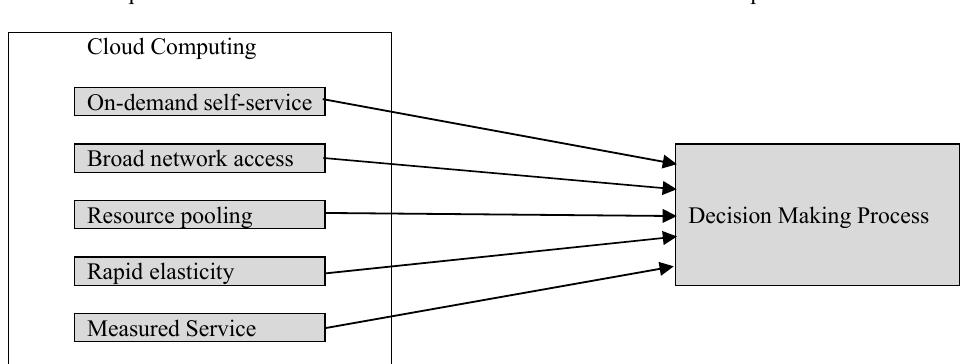
Fig. 1. The proposed study (Ahmad & Afzal, 2017; Sohaib et al., 2019; Sharma & Acharya,